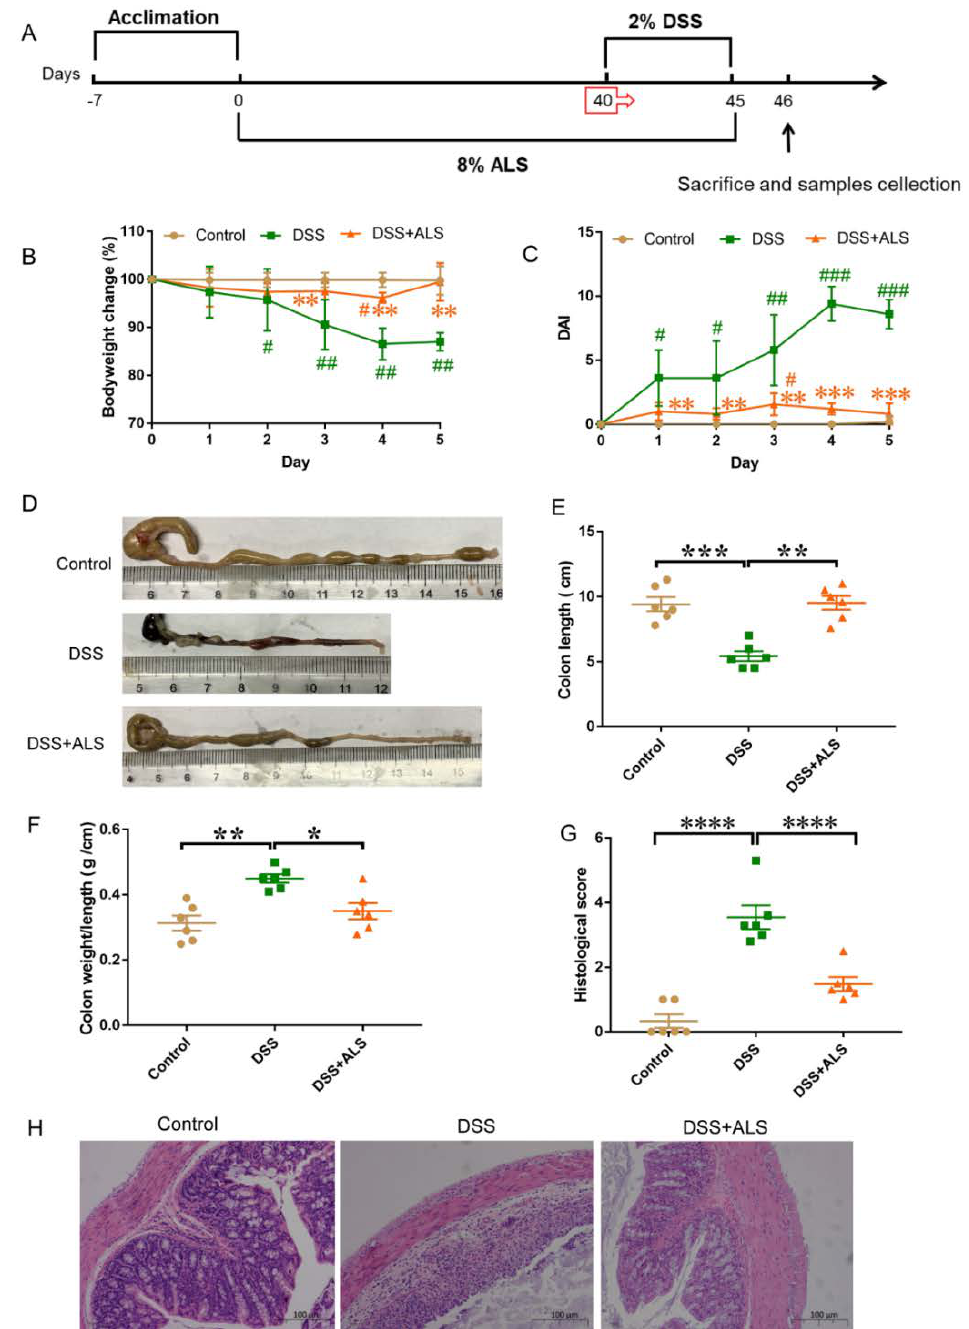
Figure 1. ALS alleviates colitis symptoms. ( A ) Study design of the experiment. ( B ) Body weight change during the induction of colitis. Data are mean ± SEM. n = 6 per group. # p < 0.05, ## p < 0.01, relative to control group; ** p < 0.01, relative to dextran sodium sulfate (DSS) group. ( C ) DAI scores during DSS-induced period. Data are mean ± SEM. n = 6 per group. # p < 0.05, ## p < 0.01, ### p < 0.001 relative to control group; ** p < 0.01, *** p < 0.001, relative to DSS group. ( D ) Pictures of colon samples showing the colon length. ( E ) Colon length. ( F ) Colon weight/length ratio. ( G ) Histological scores of the H&E-stained sections. ( H ) H&E-stained colonic sections. Scale bar = 100 µ m. Data are mean ± SEM. n = 6 per group. * p < 0.05, ** p < 0.01, *** p < 0.001 and **** p <